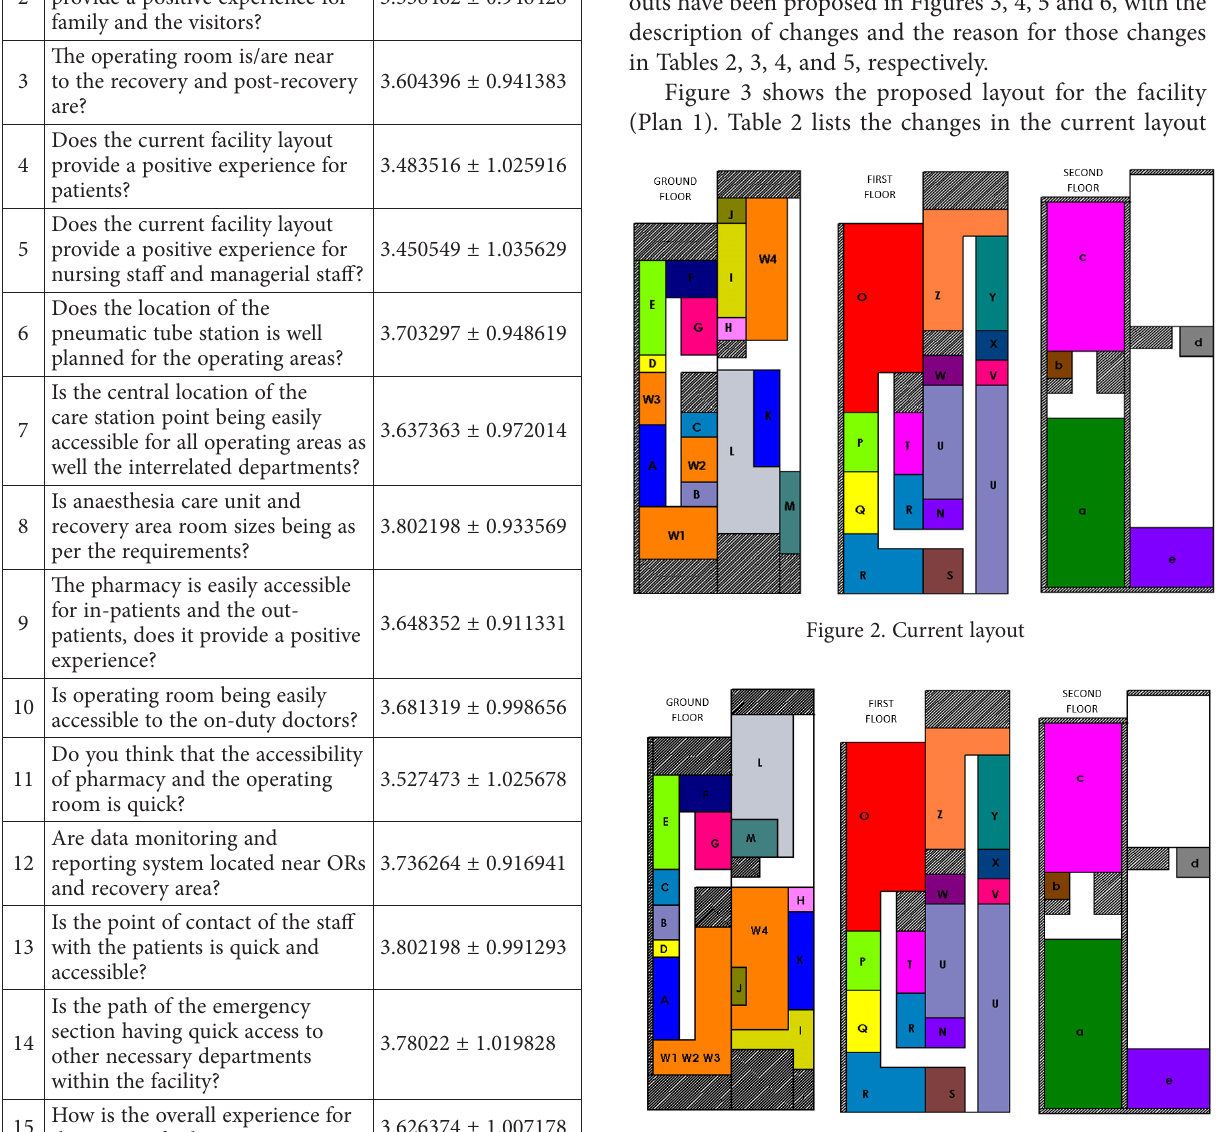
Figure 3. Proposed layout 1 (Plan